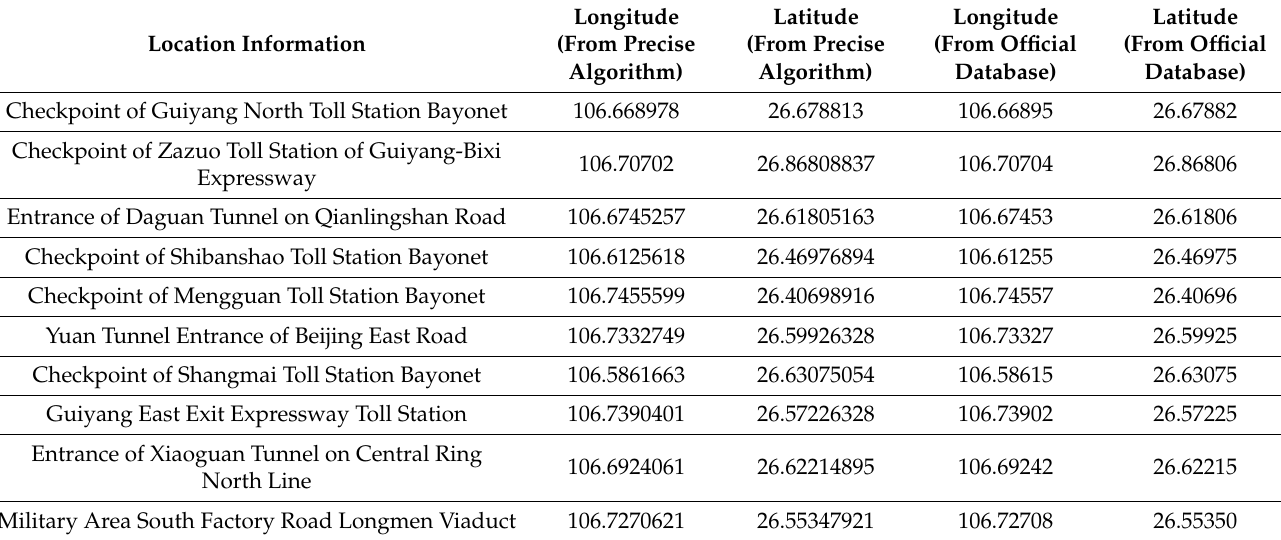
Table 6. Longitude and latitude precision data results verification comparison.